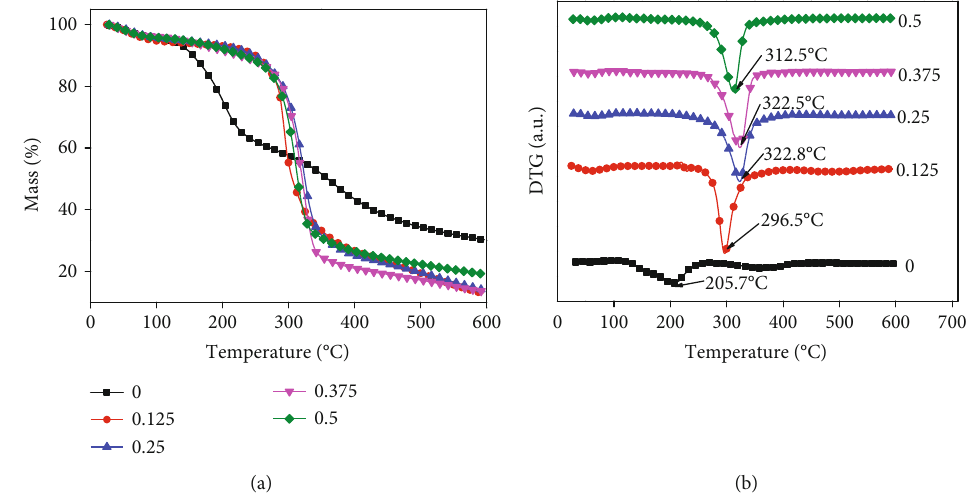
Figure 4: (a) TG curves of OWPF with di ff erent degrees of oxidation. (b) DTG curves of OWPF with di ff erent degrees of oxidation.